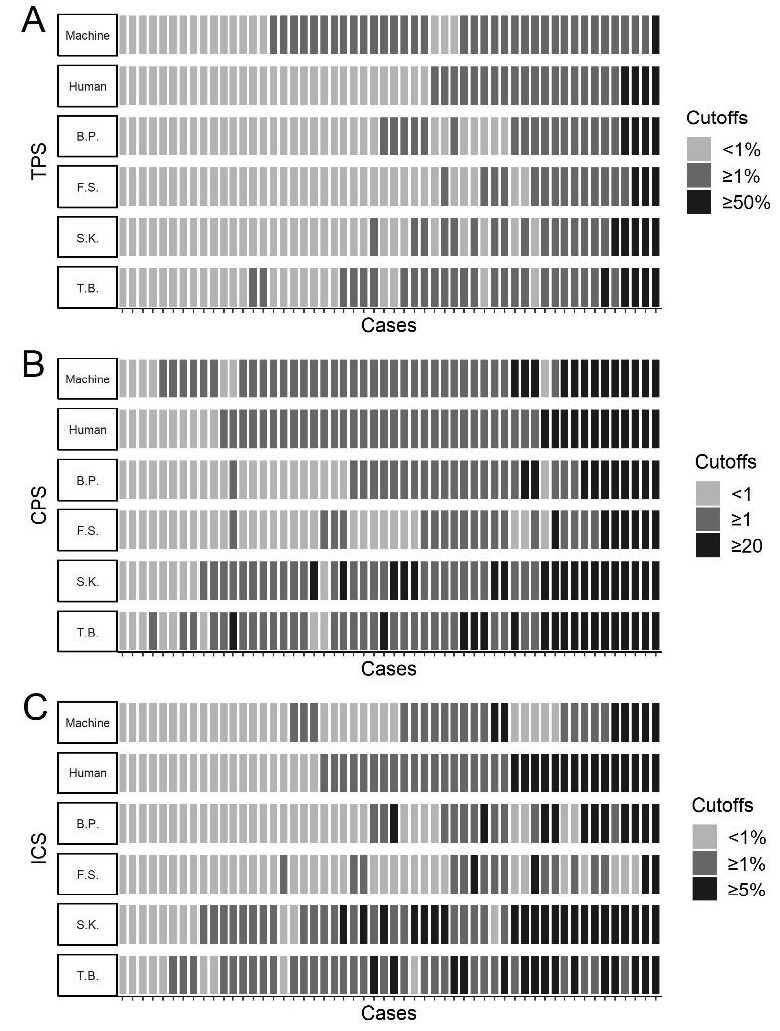
Figure 5. Agreement of PD-L1 scores by cutoffs. ( A – C ) Individual cases are shown as boxes on the y axis (Machine = automated PD-L1 scoring, Human = mean of the four human investigators, B.P., F.S., S.K. and T.B. = the four investigators in this study); ( A ) Interrater agreement of TPS. Cutoffs of <1%, ≥1%, and ≥50% were chosen; ( B ) Interrater agreement of CPS. Cutoffs of <1, ≥1, and ≥20 were chosen; ( C ) Interrater agreement of ICS. Cutoffs of <1%, ≥1% and ≥5% were chosen.